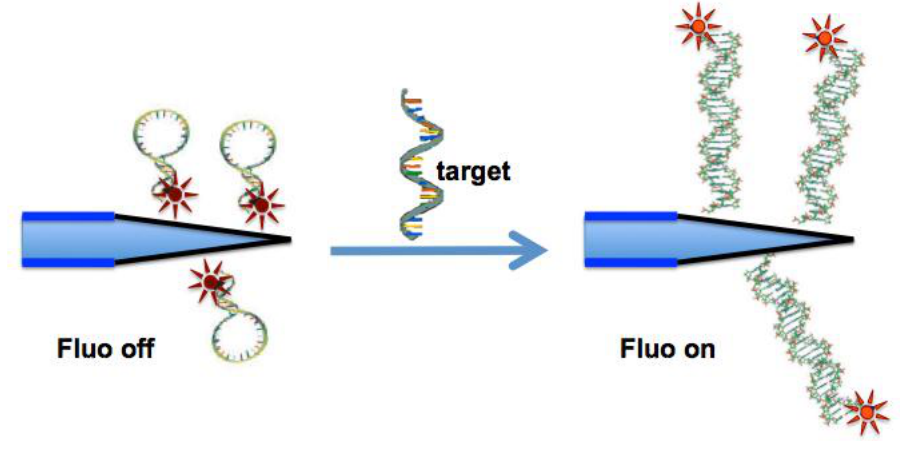
Figure 1. Scheme of the sensing